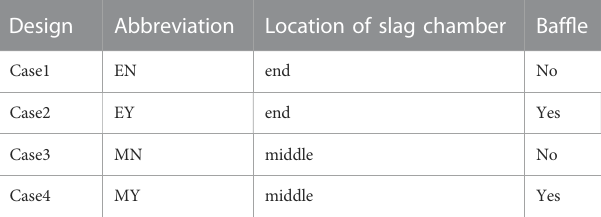
TABLE 2 Design schemes of different furnace types.